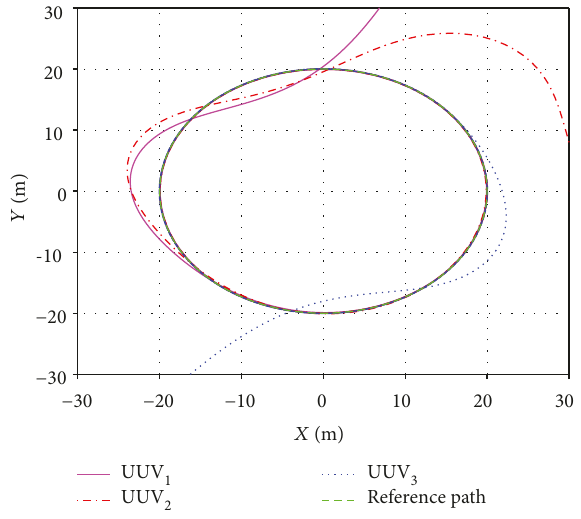
Figure 7: Paths of 3 UUVs circle curves.